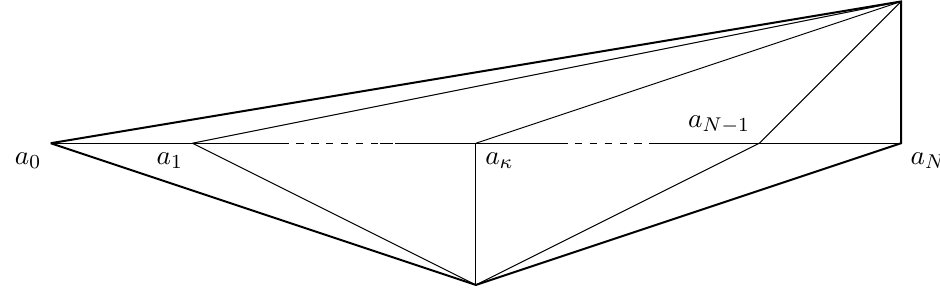
Figure 9 . Toric diagram for Y N,κ system. Here a i , i = 0 , · · · N are complex structure